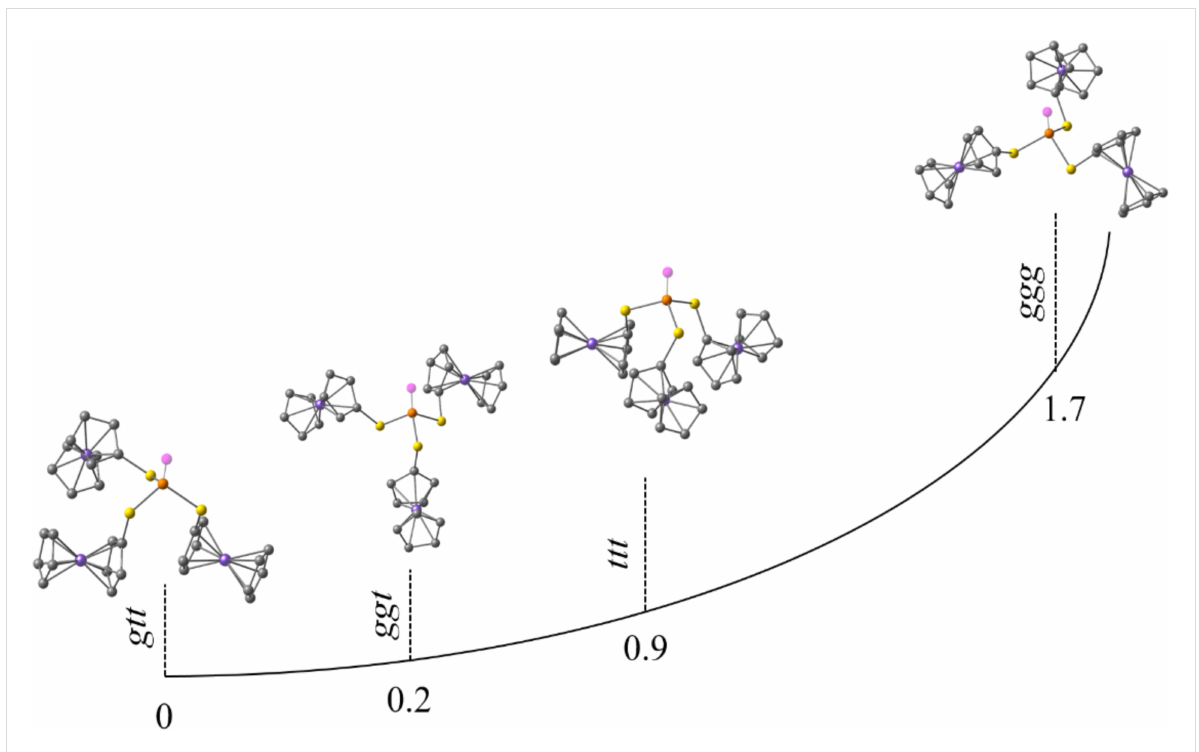
Figure 2: Optimized conformations and relative energies of four possible conformers of triferrocenyl trithiophosphite.